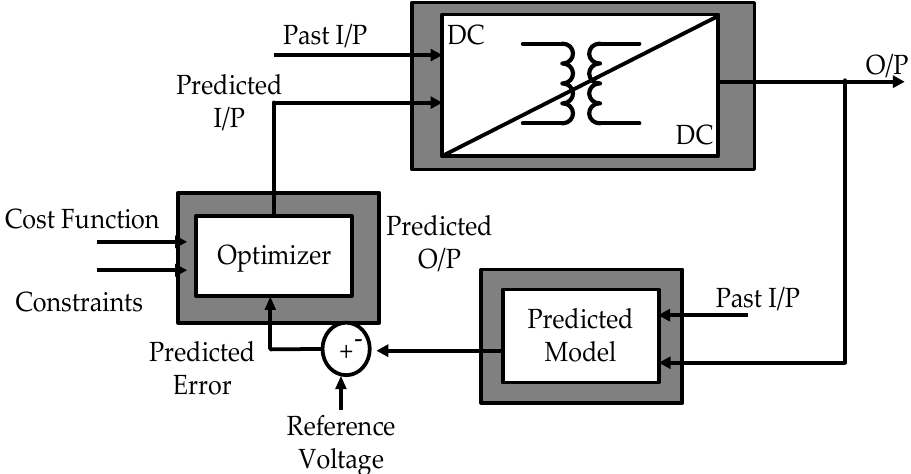
Figure 10. Block diagram of model predictive control.